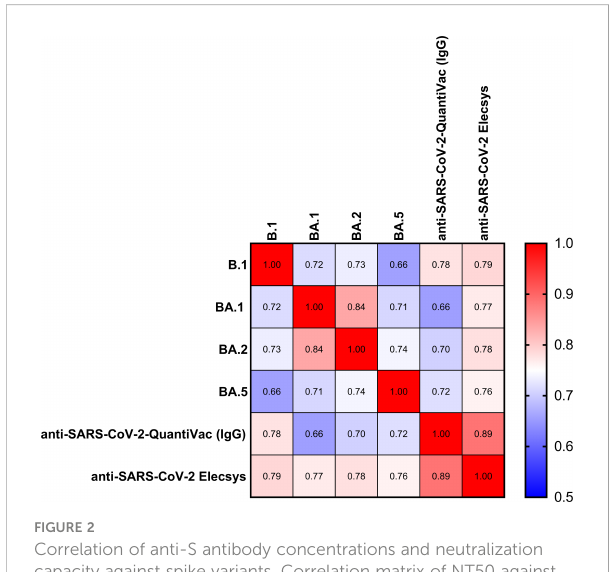
FIGURE 2 Correlation of anti-S antibody concentrations and neutralization capacity against spike variants. Correlation matrix of NT50 against BA.1, BA.2, BA5 and B.1, and anti-SARS-CoV-2-QuantiVac (IgG) ELISA and Elecsys SARS-CoV-2 based on Spearman Correlation.